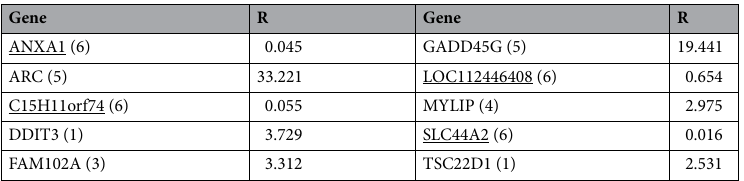
Table 2. Real-time RT-PCR analysis of 10 Bos taurus transcripts. The table shows the relative expression ratio (R) values. Names of the downregulated genes are underlined. (The number of the cluster to which the gene belongs is shown in